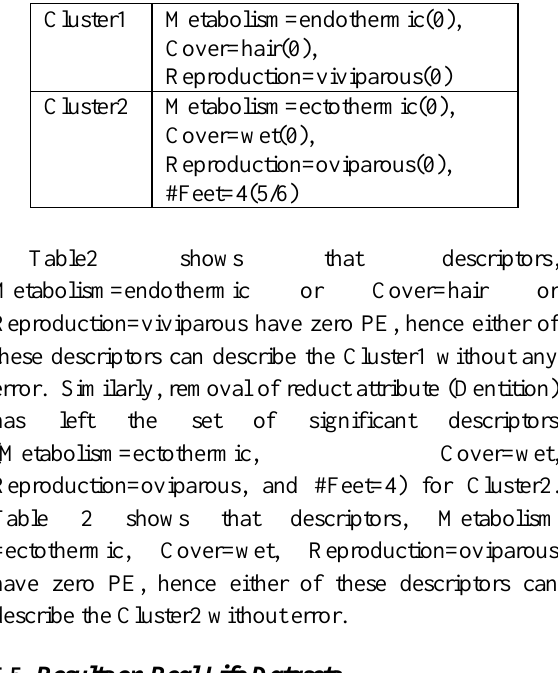
Table 2: Significant descriptors in clusters